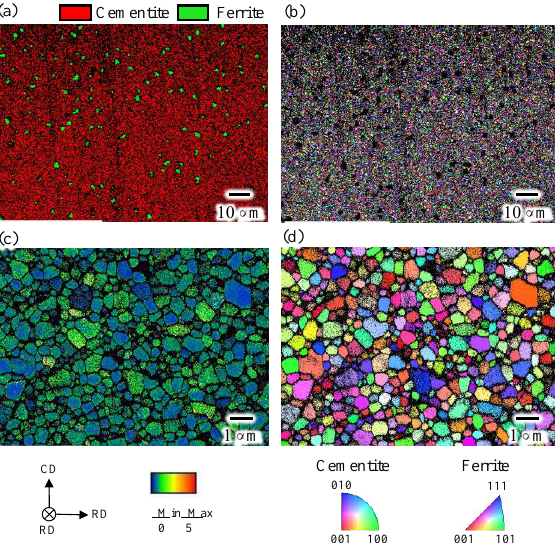
Figure 2. ( a ) Phase, ( b , d ) inverse pole figure (IPF), and ( c ) kernel average misorientation maps of the as-sintered bulk cementite sample.